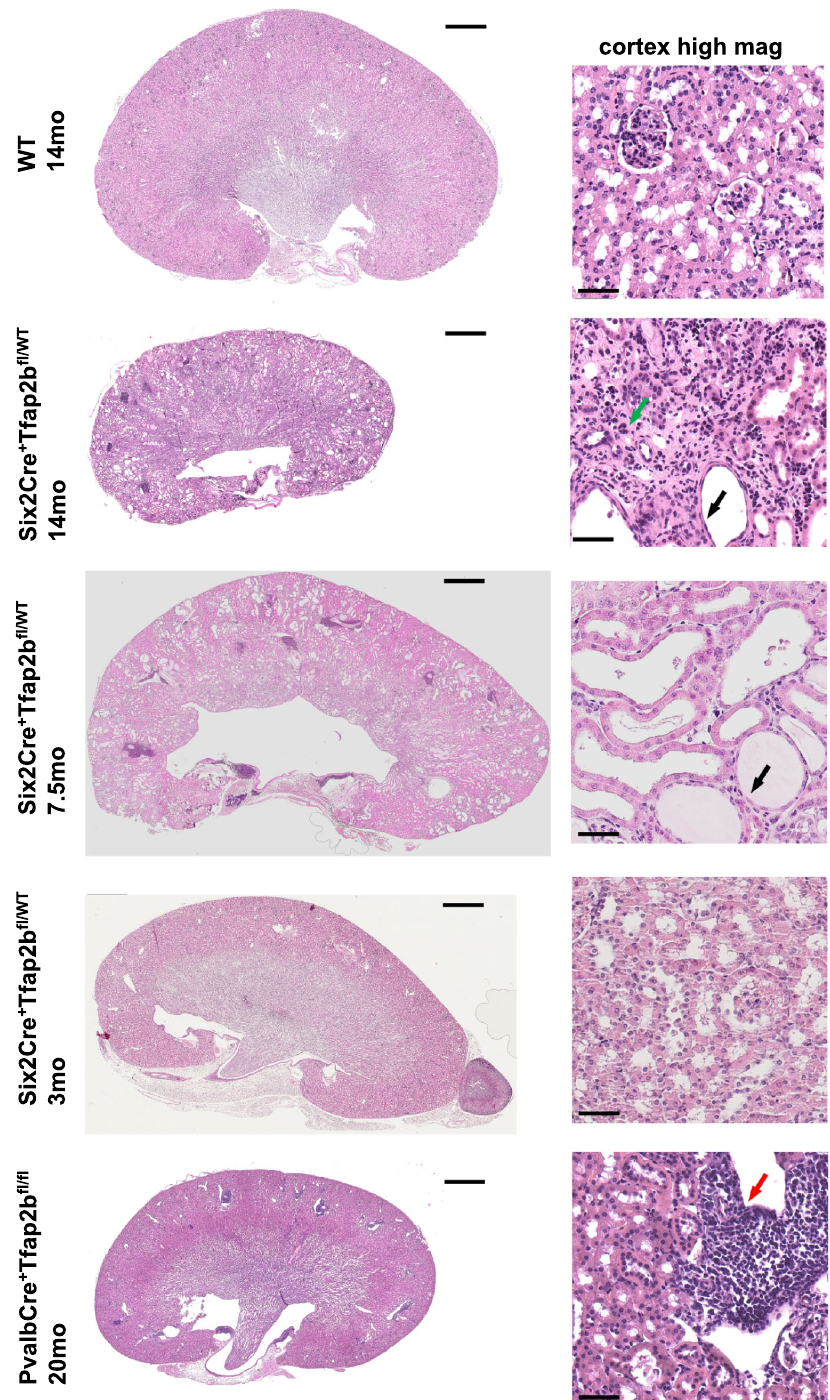
Fig. 7 Progressive histomorphologic renal abnormalities in mice with heterozygous inactivation of AP-2 β in NPC-derived nephron segments. H&E sections (left: whole kidney; right: high magni fi cation image of the same kidney) show that Six2Cre + Tfap2b fl /WT mice have a normal-appearing kidney at 3-months of age but develop severe distal nephron abnormalities with distal tubule dilatation (black arrows) and a tubulointerstitial in fl ammatory in fi ltrate (green arrow) at 7.5 and 14 months of age. In contrast, 20-monhts-old PvalbCre + Tfap2b fl / fl mice show less severe abnormalities and in fl ammatory in fi ltrates (red arrow). Scale bars, 1 mm left and 50 μ m